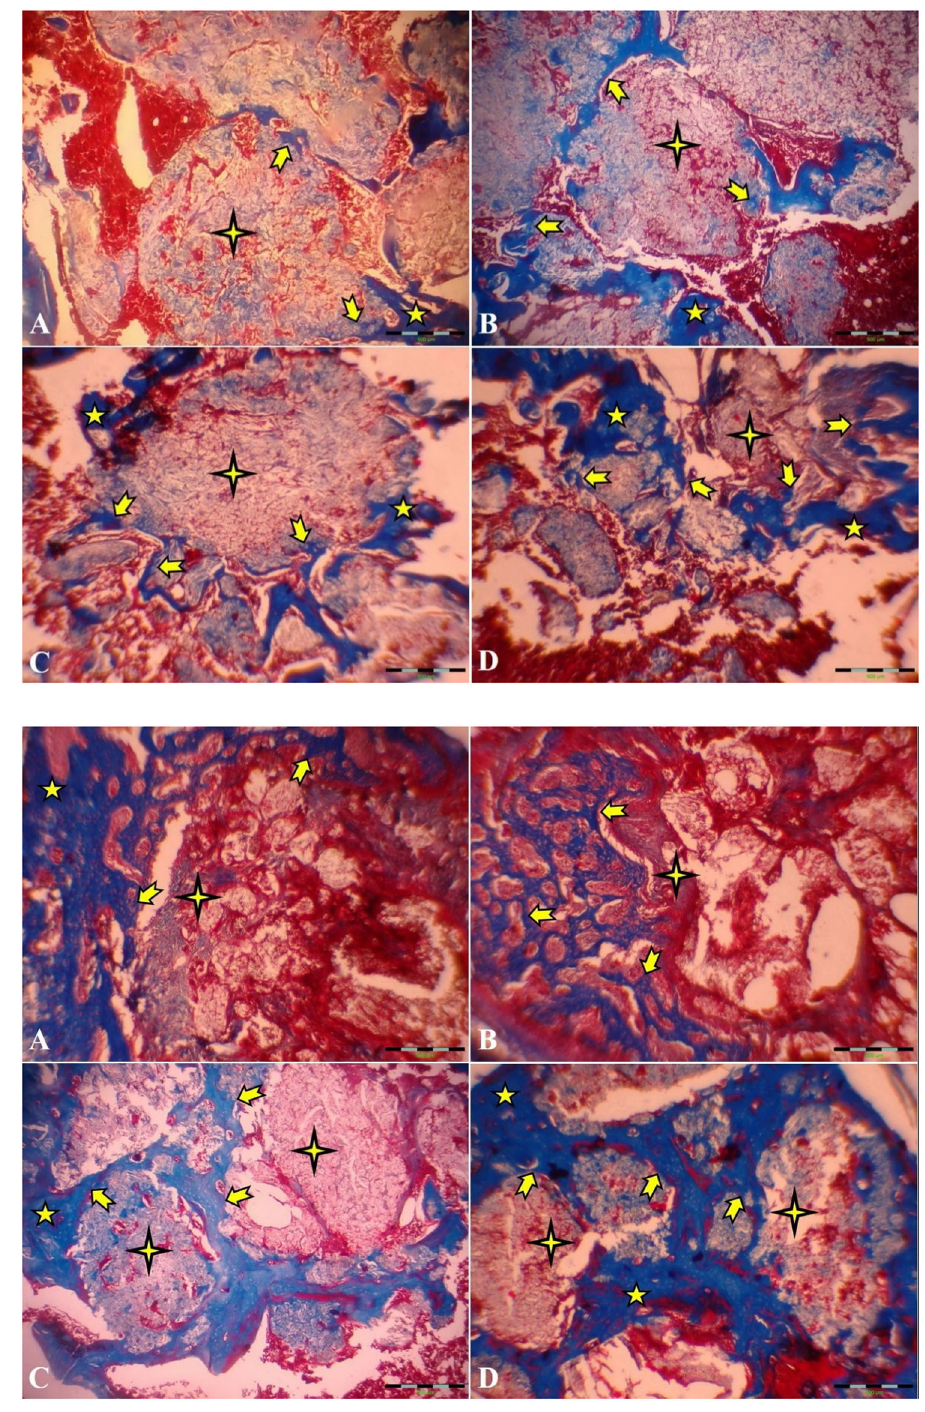
Fig. 7 Microscopic section from the healing site of defect on the 45th day postoperation. bones around the defective area. B The autograft group shows more lamellar bone formation than the control group. C HA group had a well-developed lamellar bone around the defect. D TCP-TiO2 group induced the most lamellar bone in the center of the defect (Trichrome × 40).